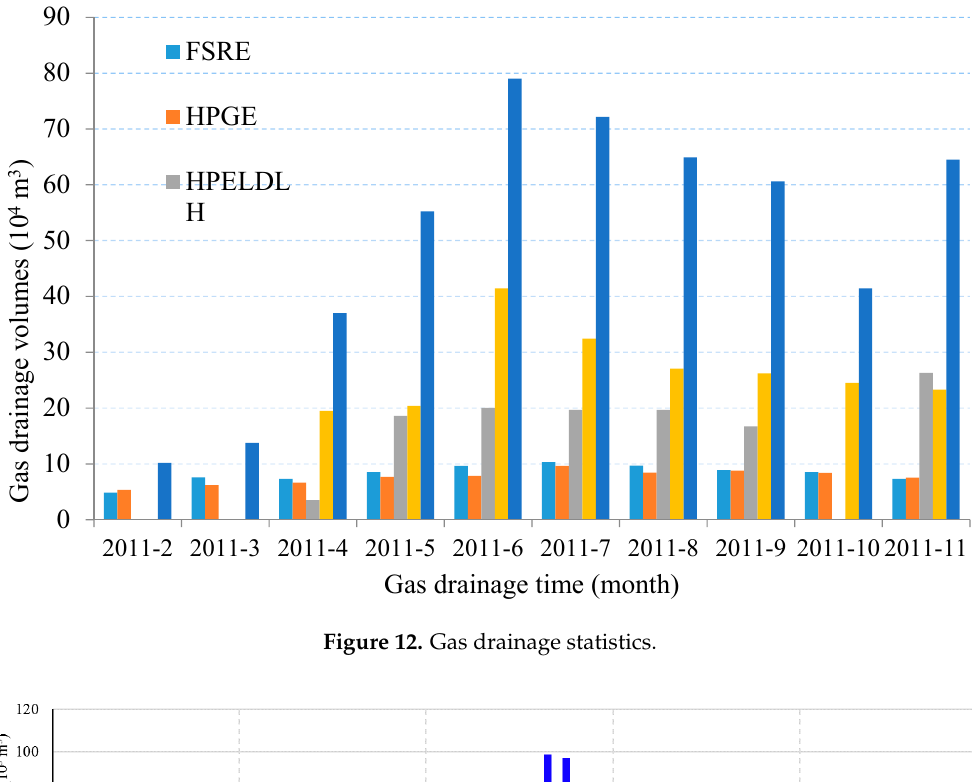
Figure 12. Gas drainage statistics.